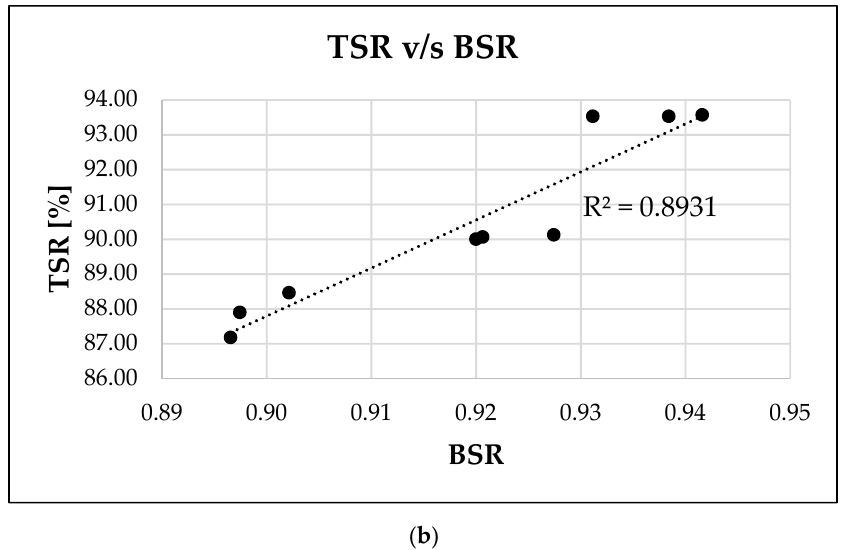
Figure 8. Correlation between the ITS and BBS test: ( a ) ITS dry vs. Pull-Off Tensile Strength (POTS) dry and ( b ) TSR vs. BSR.